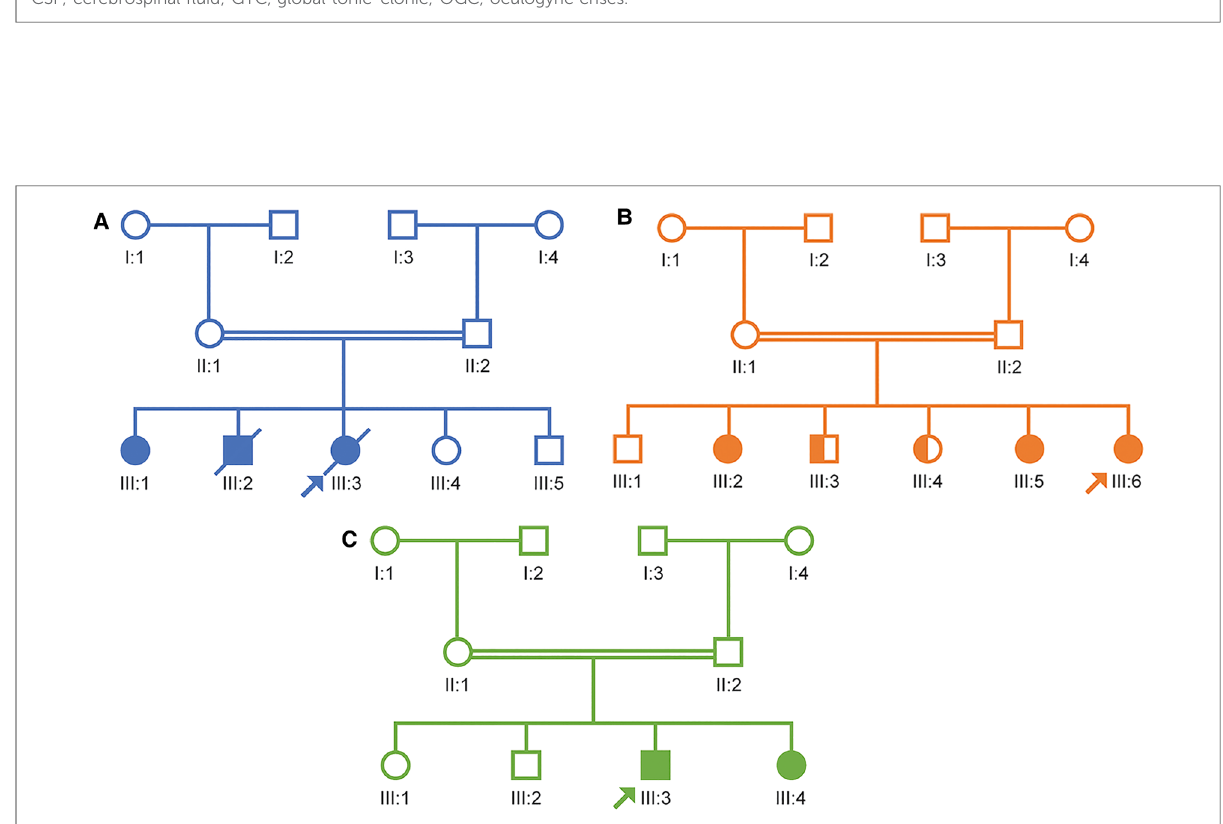
FIGURE 1 Timeline for the diagnosis and management of the three case study patients. AADC, aromatic L-amino acid decarboxylase; AED, anti-epileptic drug; CSF; cerebrospinal fl uid; GTC, global tonic-clonic; OGC, oculogyric crises.